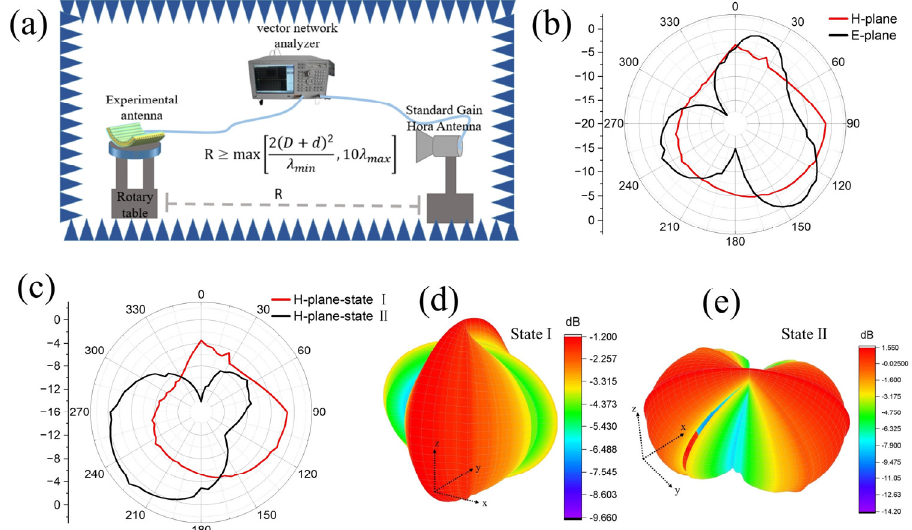
Figure 5. ( a ) Schematic diagram of the normalized radiation patterns. ( b ) Radiation patterns of the E ‐ and H ‐ planes of the bi ‐ stable antenna at state I. ( c ) Radiation patterns of the H ‐ plane of the bi ‐ stable antenna at states I and II, respectively. ( d ) 3D radiation pattern of state I. ( e ) 3D radiation pattern of state II at 3.5 GHz.